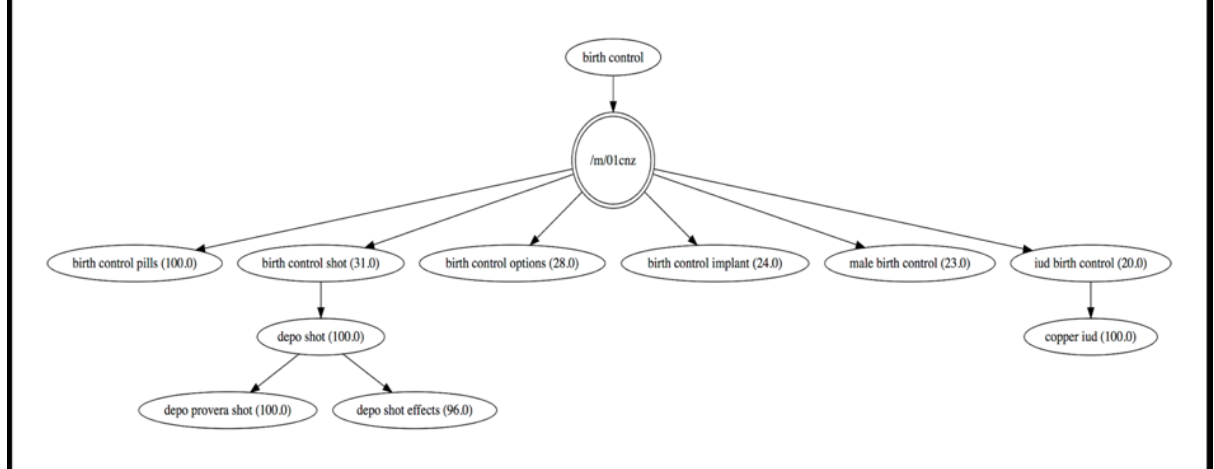
Figure 2. Top queries for birth control in the United States in 2017. Single circles in the graph represent search queries, whereas a double circle indicates an overarching topic coded for internal organizational purposes within the Google application programming interface (API) and is not included in the list of top queries. Numbers in parentheses indicate how relation of query to the provided initial search term. iud: intrauterine device.